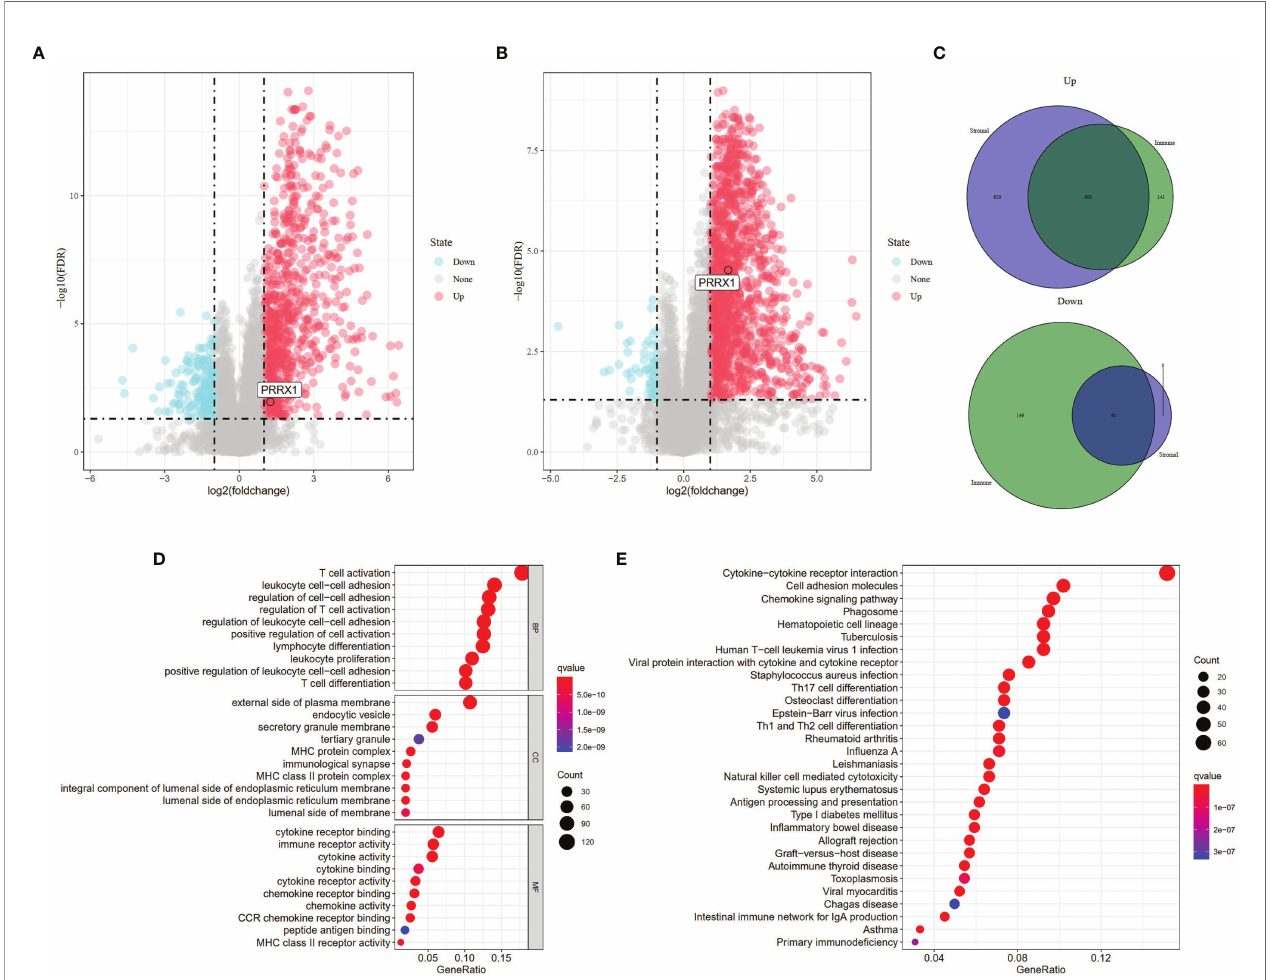
FIGURE 3 | Identi fi cation of DEGs based on different scoring systems and related functional annotations. Analysis of DEGs based on (A) Immune scores (FDR <0.05, | log2(fold change)| >1 and (B) Stromal scores (FDR <0.05, |log2(fold change)| >1). Red or blue dots represent genes that were signi fi cantly upregulated or downregulated in each comparison (high vs. low). (C) Identi fi cation of the 739 overlapping genes commonly upregulated or downregulated in the two scoring systems. (D) GO enrichment analysis ( p < 0.05, q < 0.05) and (E) KEGG pathway enrichment analysis ( p < 0.05, q < 0.05) of the 739 overlapping genes. Dots size represented the number of enriched genes, the color represented q -value; the redder the color, the smaller the q